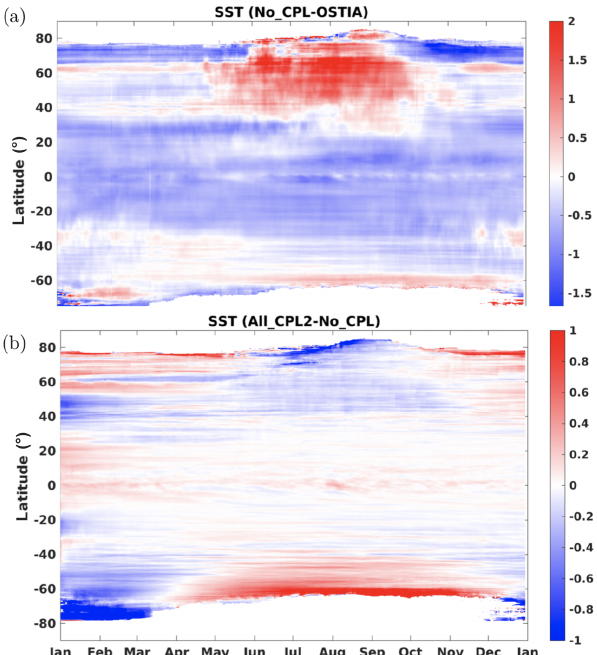
Figure 14. Hovmöller diagram of the longitudinally averaged sea surface temperature ( ◦ C) differences between (a) No_CPL and OS- TIA and (b) between All_CPL2 and